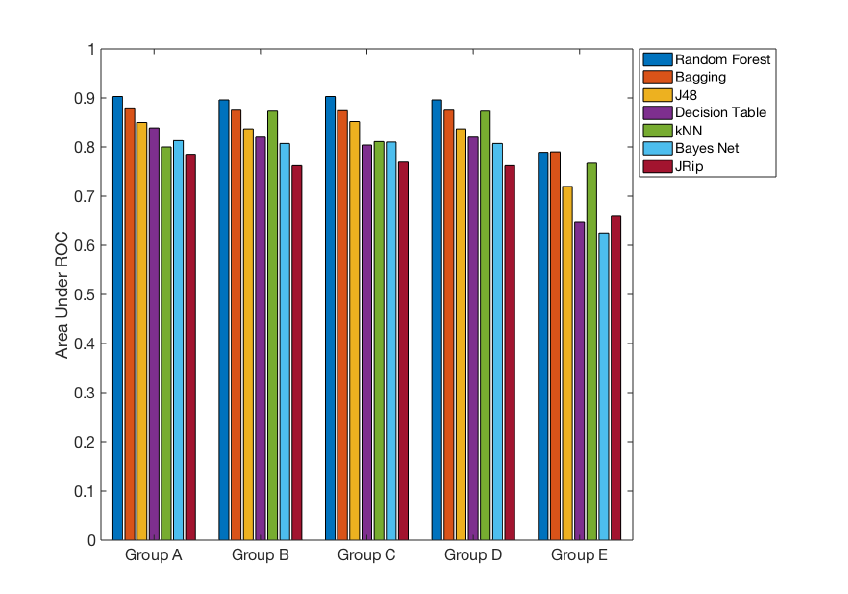
Figure 4. Top seven classification algorithms performed in terms of Area under the ROC Curve and accuracy out of ten algorithms that we used in this study. Group details are shown in Table 5.